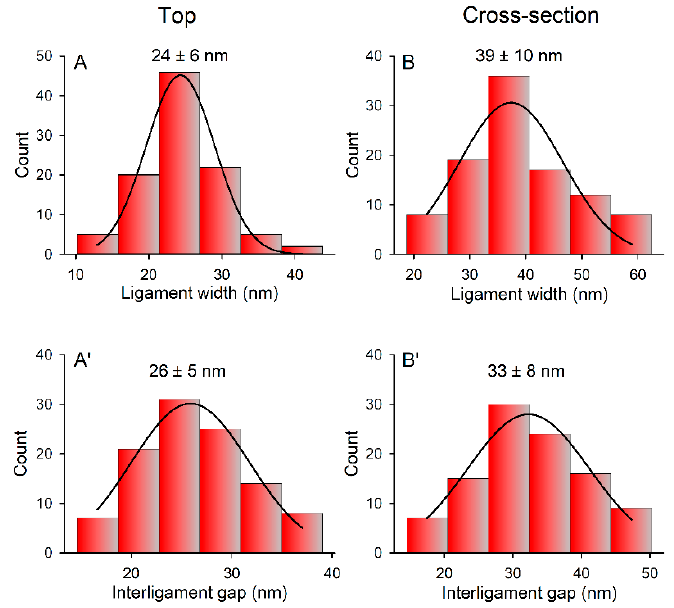
Figure 3. Size distribution of ligament width ( A , B ) and interligament gap ( A’ , B’ ) of the top or exterior ( A , A’ ) and cross-sectional or interior ( B , B’ ) regions of np-Au.